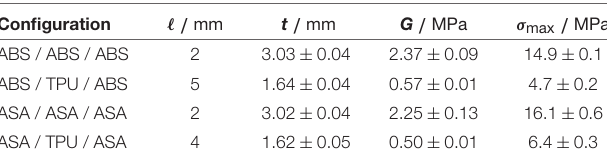
TABLE 2 | Lap shear